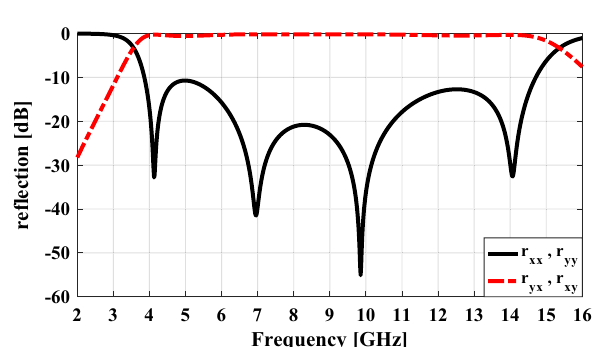
Figure 4. Simulated results of the co- and cross-polarization